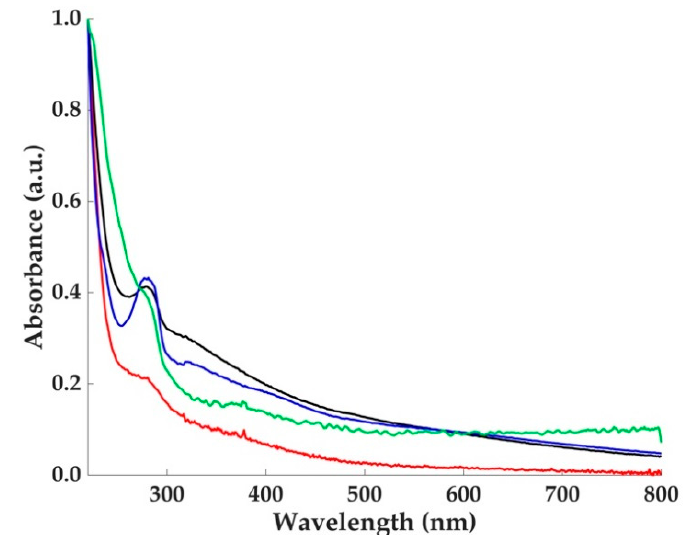
Figure 2. Ultraviolet-visible (UV-Vis) absorption spectra of Sc-Ms1 melanin (red line), melanin-like pigment synthesized by Sc-Ms1 tyrosinase (black line), dopa (blue line), and cysteinyldopa (green line) melanin-like pigments synthesized by Tv laccase. An excess of dopa was used as substrate for the enzymic synthesis. The peak at 274 nm is dependent on unreacted substrate and the presence of protein.